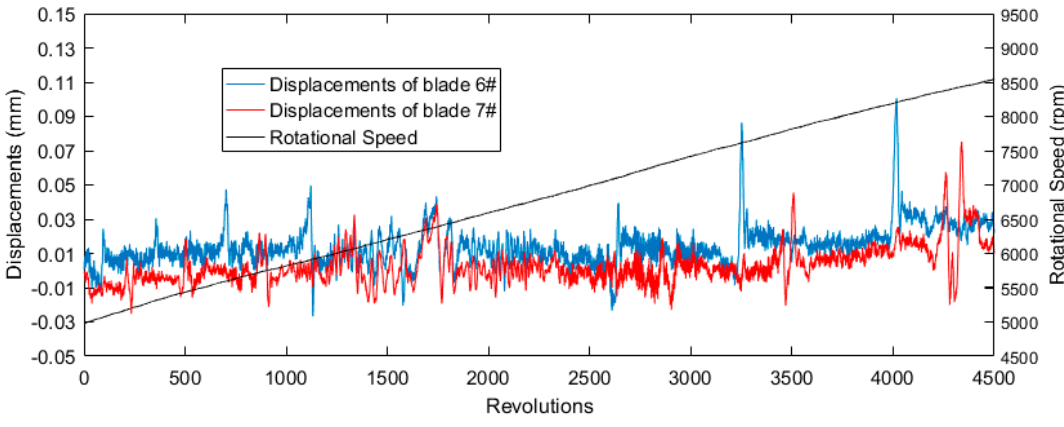
Figure 5. Blade vibration deflection and rotation speed waveforms.